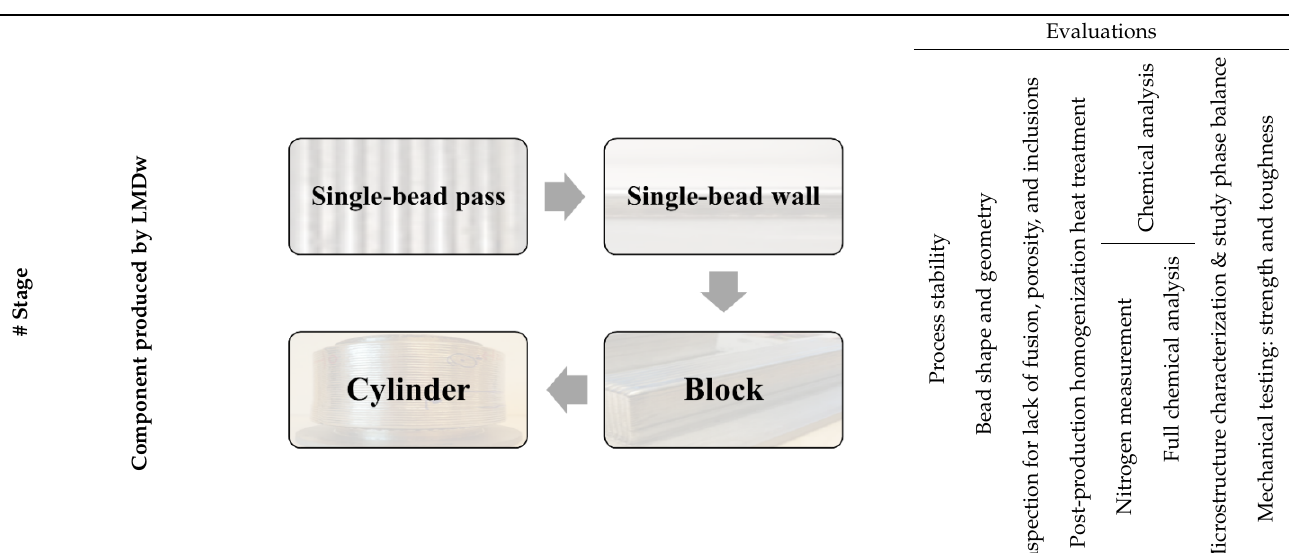
Table 2. Chemical compositions of the plate and wire (wt.%).